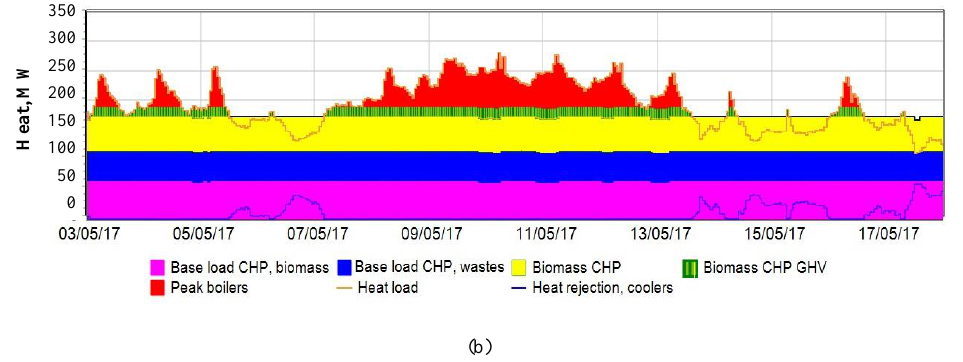
Fig. 4. Scenario A: example of CHP operation (a) without and (b) with an accumulator tank (7000 m 3 ). Fig. 5 depicts the situation, where only power generated during the CHP mode is subsidised, the coolers are not installed, and all the heat generated must be stored or consumed (Scenario B). When it is impossible to store the generated heat (Fig. 5(a)) and the heat load is lower than the CHP capacity, the DH operator turns off the CHP; and when the heat load is higher, peak boilers are utilised.